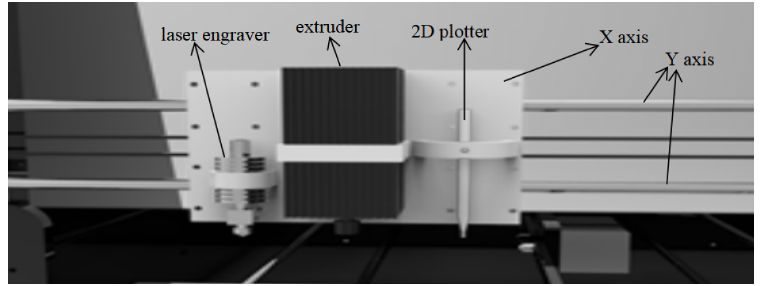
Figure 1. Laser engraving machine converted from a 3D printer.